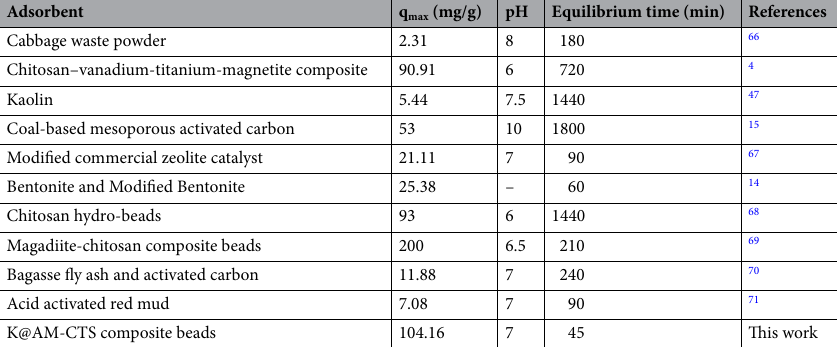
Table. 5.. Comparison of various adsorbents for adsorption of CR dye.